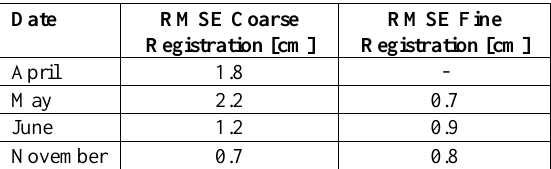
Table 3. Root mean square error of the registration steps